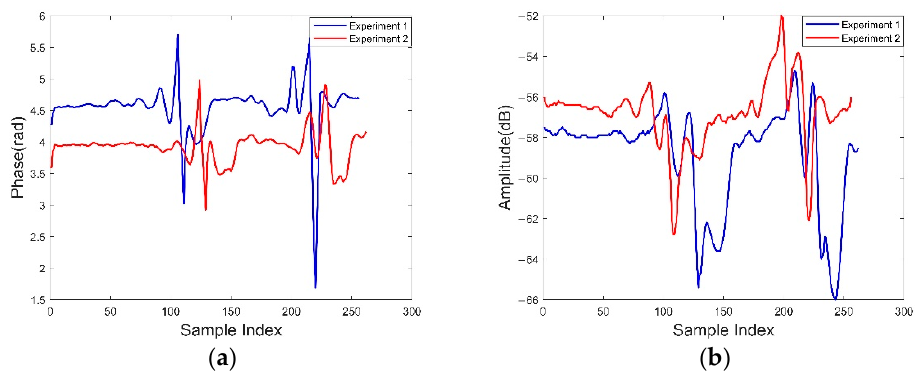
Figure 4. Phase and amplitude of two volunteers as they pass continuously: ( a ) Phase presentation of two volunteers under different experiments; ( b ) Amplitude presentation of two volunteers under different experiments.